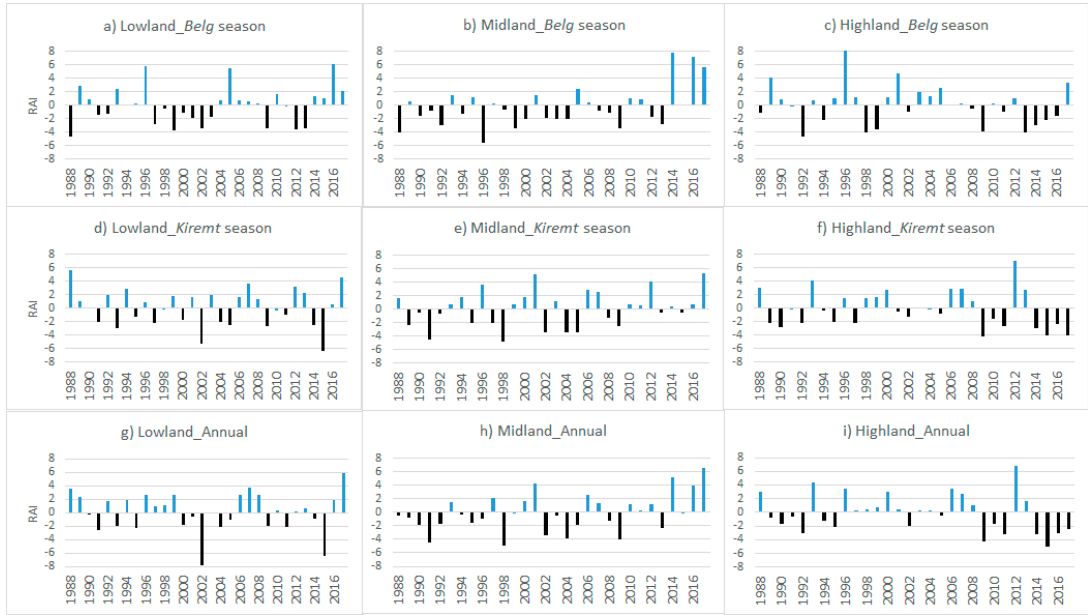
Figure 3. Trends of annual rainfall anomaly index by agro-ecological settings and season (1988–2017).